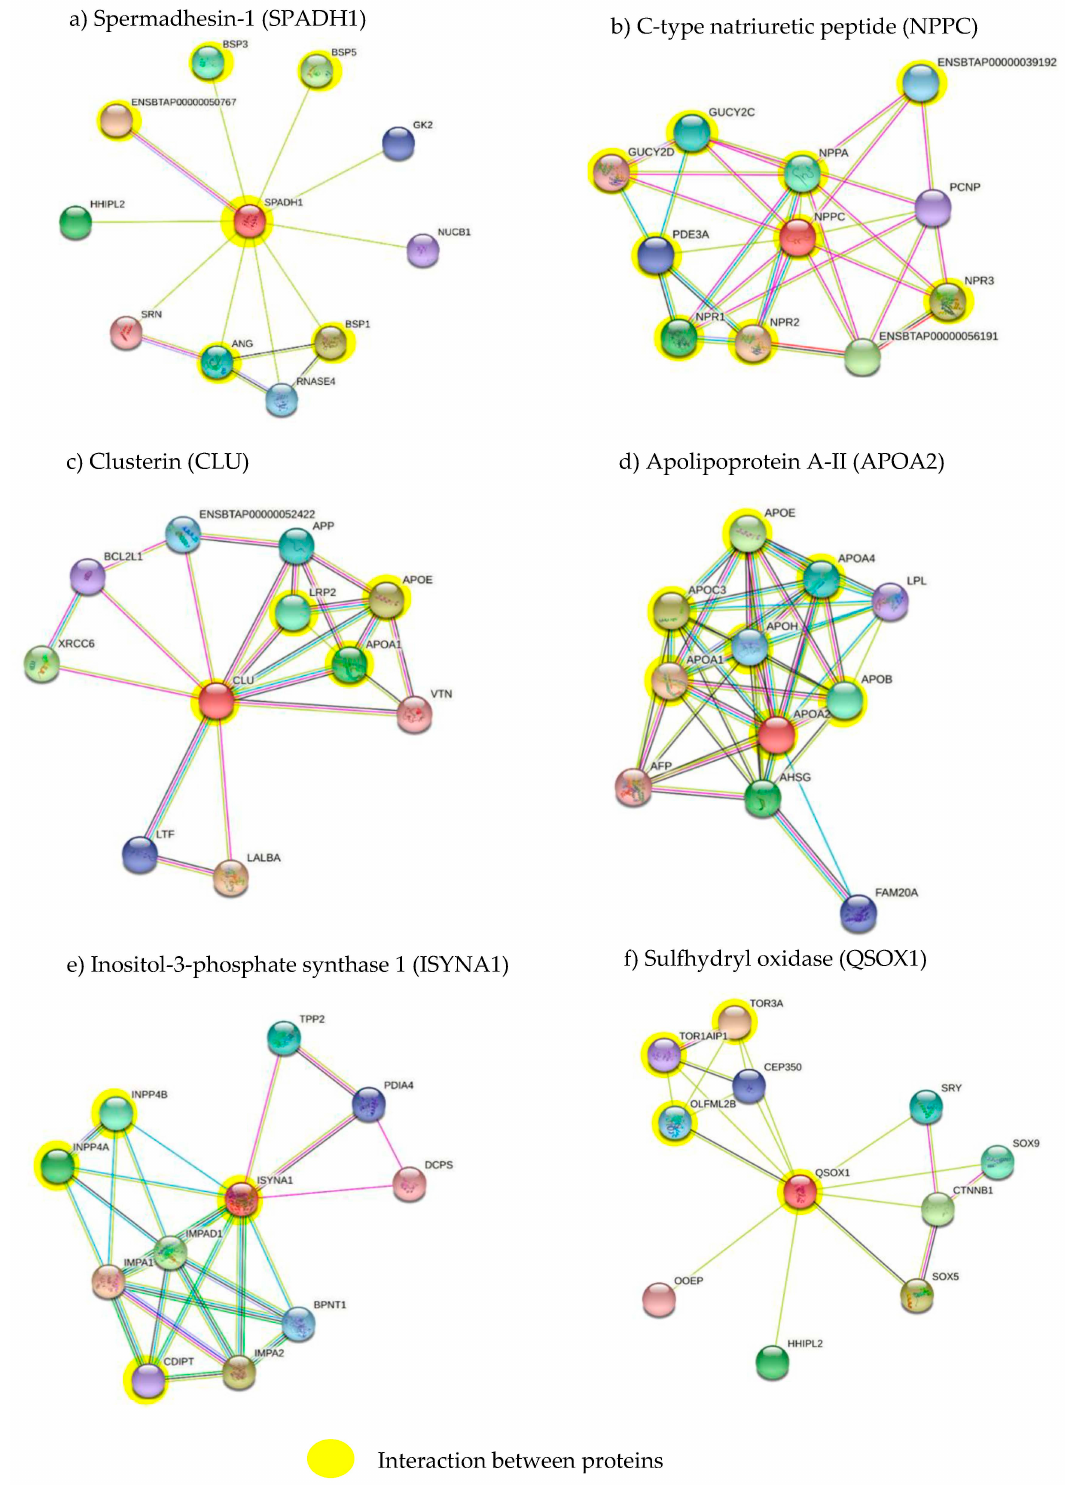
Figure 3. Interactions of the seminal plasma proteins related to sperm fertility: ( a ) Spermadhesin-1 (SPADH1); ( b ) C-type natriuretic peptide (NPPC); ( c ) clusterin (CLU); ( d ) apolipoprotein A-II (APOA2); ( e ) inositol-3-phosphate synthase 1 (ISYNA1); ( f ) sulfhydryl oxidase (QSOX1).